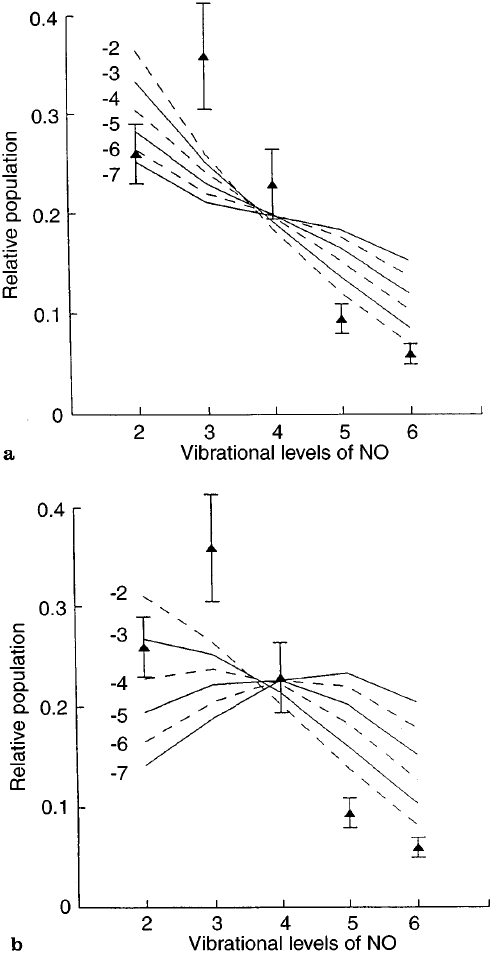
Fig. 2a,b. The averaged deviation of calculated NO populations from experimental data versus (cid:97) for (cid:68) h (cid:136) 4km and (cid:107) 1 (cid:136) ) 7– ) 2: a n (cid:136) 1, b